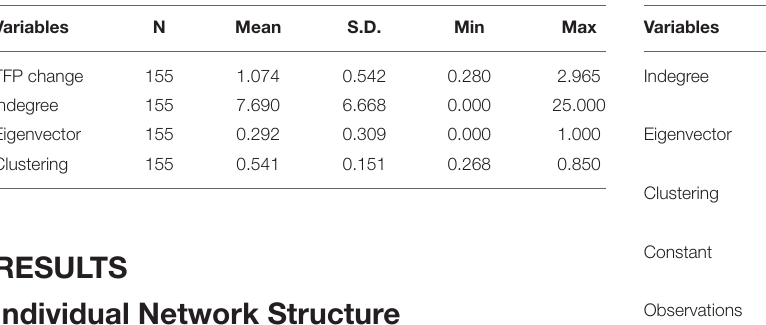
TABLE 3 | Descriptive statistics. TABLE 4 | Regression